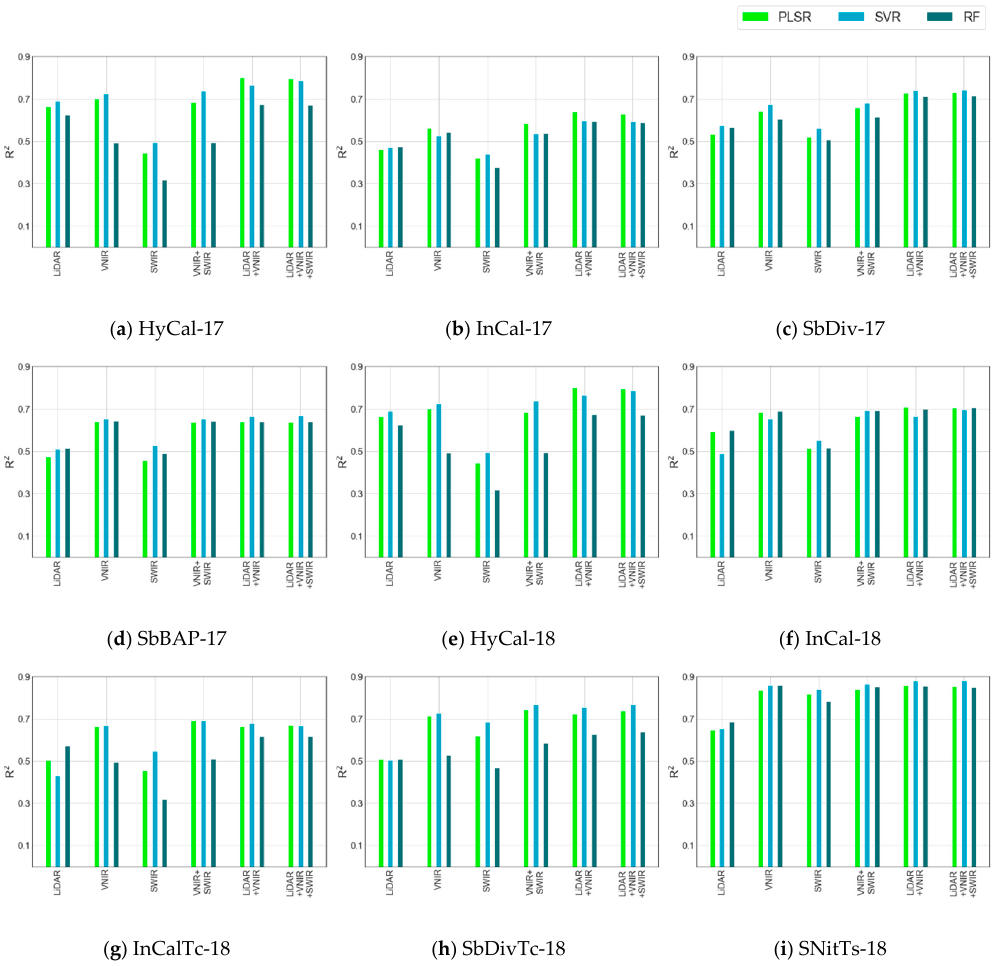
Figure 18. R 2 values of the end of season fresh biomass predictions, using six data sources, and the three partial least squares regression (PLSR), support vector regression (SVR), and Random Forest (RF) methods for all the experiments conducted in the 2017 and 2018 growing seasons.